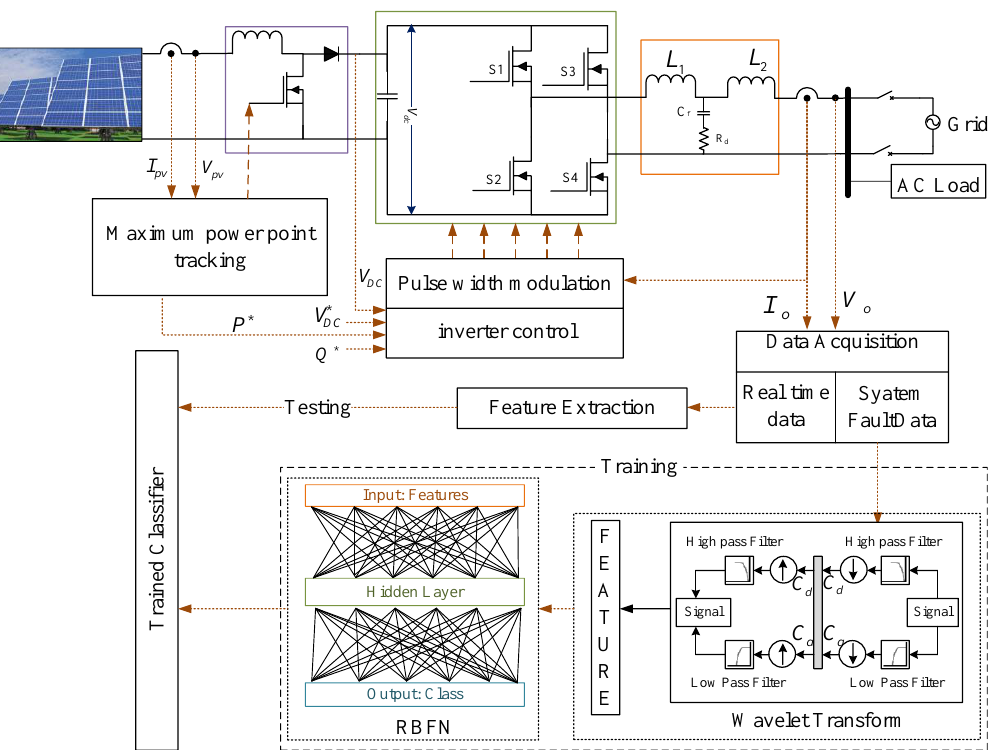
Figure 1. Proposed fault classification process is standalone PV system.